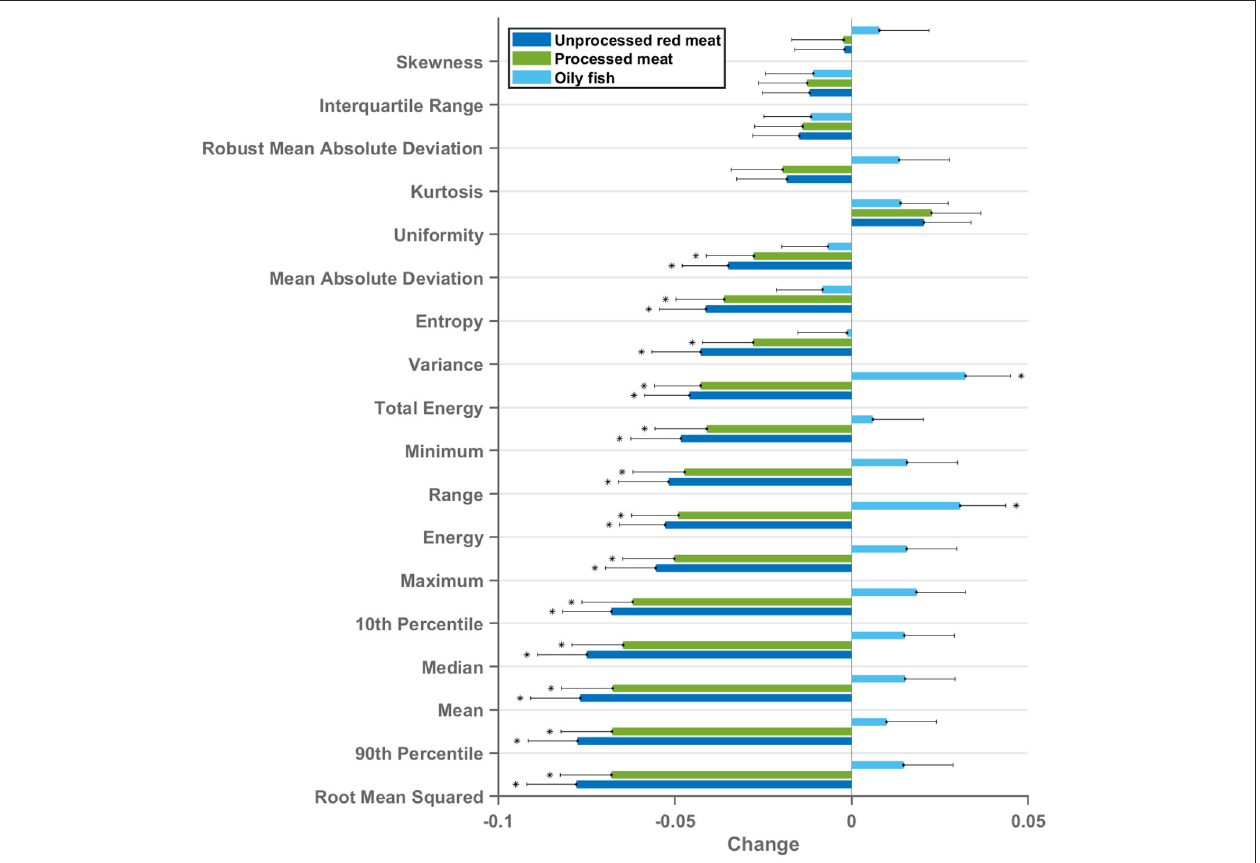
FIGURE 4 | Multivariable linear regression models showing change in LV myocardium CMR first-order radiomics (end-diastole) per 100g increase in daily meat consumption. Each bar represents standardised beta coefficients corresponding to the indicated radiomics first-order feature. Each bar is from a separate model adjusted for age, sex, social deprivation, educational level, smoking, alcohol intake, and exercise level. Black lines represent half-length of confidence interval for the corresponding bar. Bonferroni adjusted significance threshold p = 0.0009 (corrected for 54 comparisons). CMR, cardiovascular magnetic resonance; LV, left ventricle.